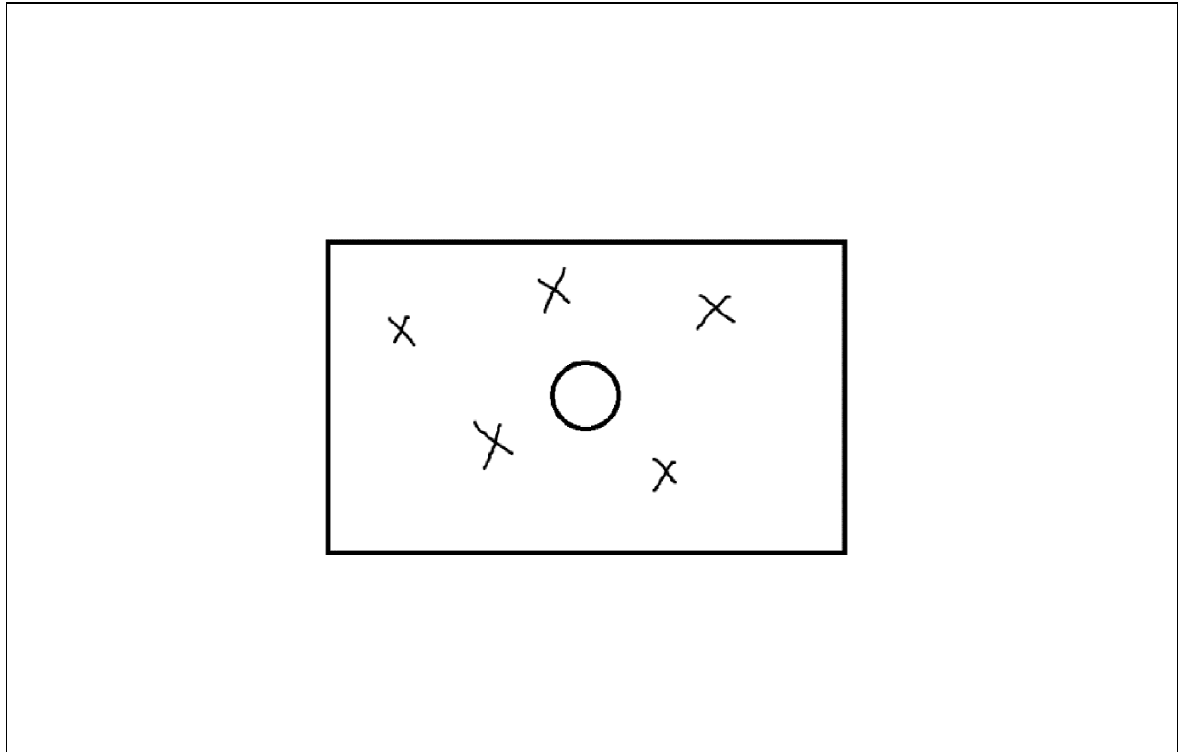
Figure 3 Using field notes, we redrafted the picture the city official